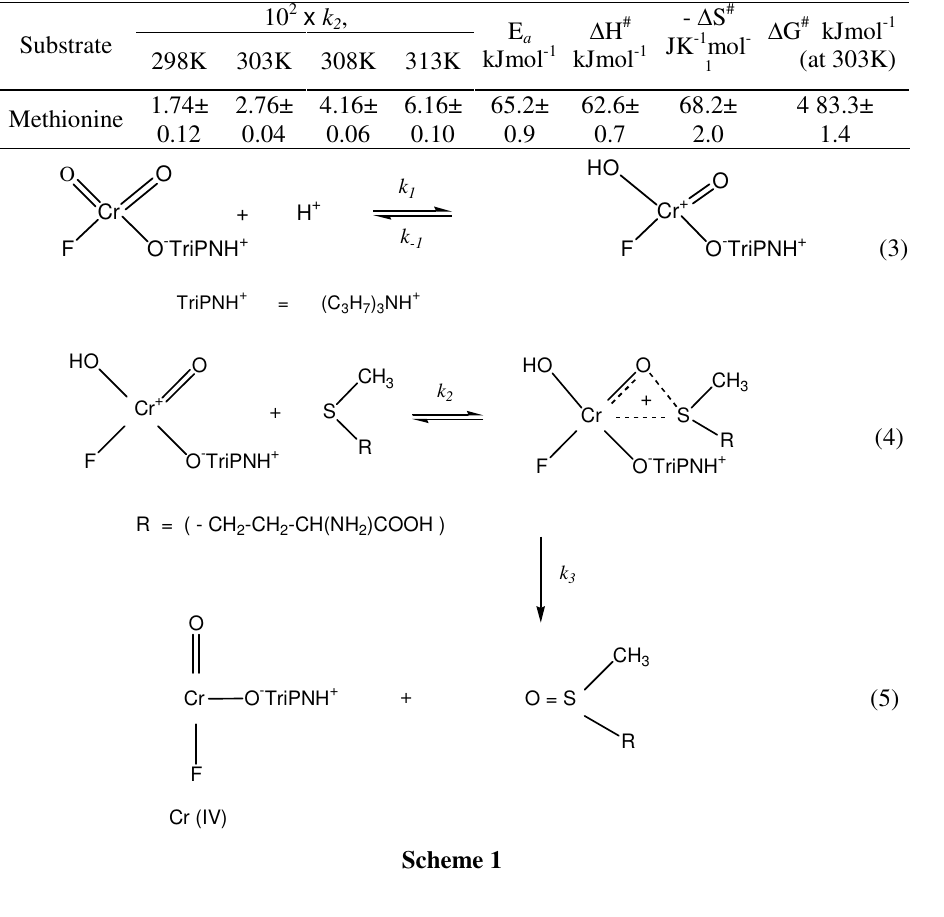
Table 3. Activation parameters and second order rate constants for the oxidation